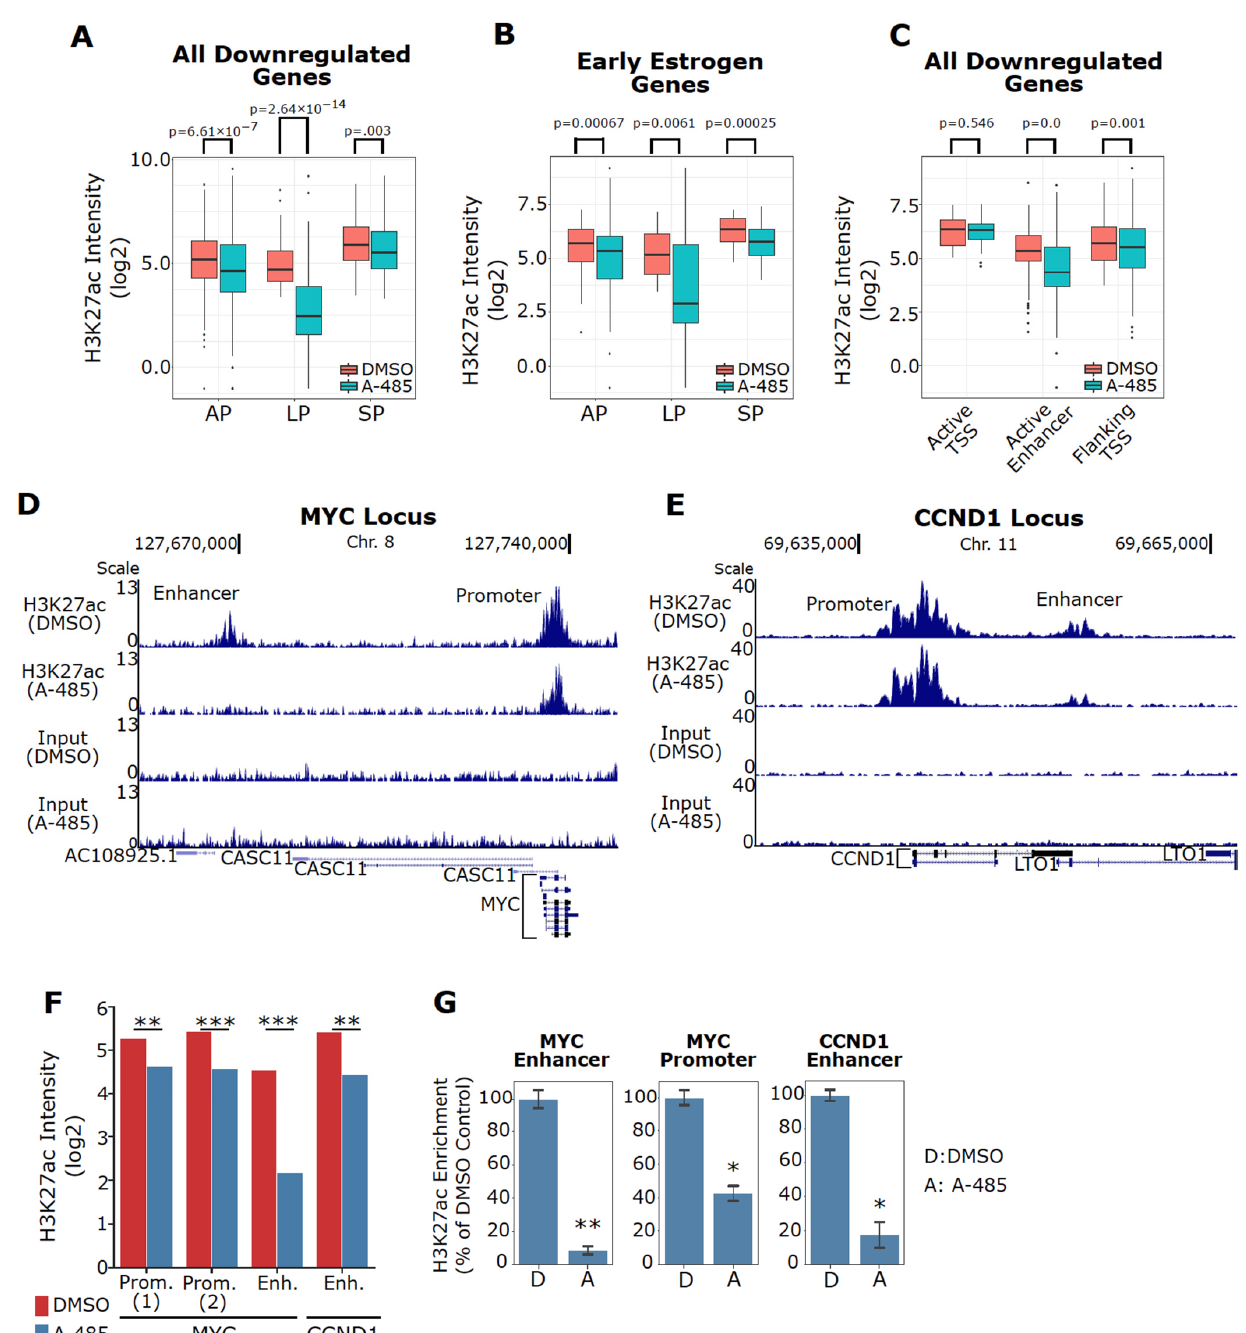
Figure 6. Specific inhibition of H3K27ac at ER target genes by A-485. ( A ) A-485 reduces H3K27ac intensity at the genes downregulated by A-485 in MCF-7 cells. ( B ) A-485 specifically reduces H3K27ac levels at estrogen-regulated genes that are repressed by A-485. The estrogen-regulated genes are from the members of the GSEA Estrogen Early Hallmark Gene Set. ( C ) A-485 reduces H3K27ac at active enhancers associated with transcriptionally downregulated genes identified in the microarray dataset (Figure 4A) in MCF-7 cells. ( D , E ) A UCSC genome browser track for the MYC ( D ) or CCND1 ( E ) locus. A-485 reduces H3K27ac at the MYC promoter and an ER-responsive upstream enhancer ( D ), while inhibiting H3K27ac at a CCND1 ER-responsive downstream enhancer ( E ) in MCF-7 cells. ( F ) Fold changes of H3K27ac intensity of ChIP-seq peaks associated with the MYC promoter (Promoter Peak 1 and Peak 2), MYC Enhancer, and CCND1 enhancer. ( G ) Validation of A-485-mediated inhibition of H3K27ac at the MYC promoter, MYC enhancer and CCND1 enhancer in MCF-7 cells, as measured by ChIP-qPCR ( n = 2). *: p < 0.05; **: p < 0.005; *** p < 0.0005 (Poisson regression model by HomeR in panel F and Student’s t -test in panel G ).